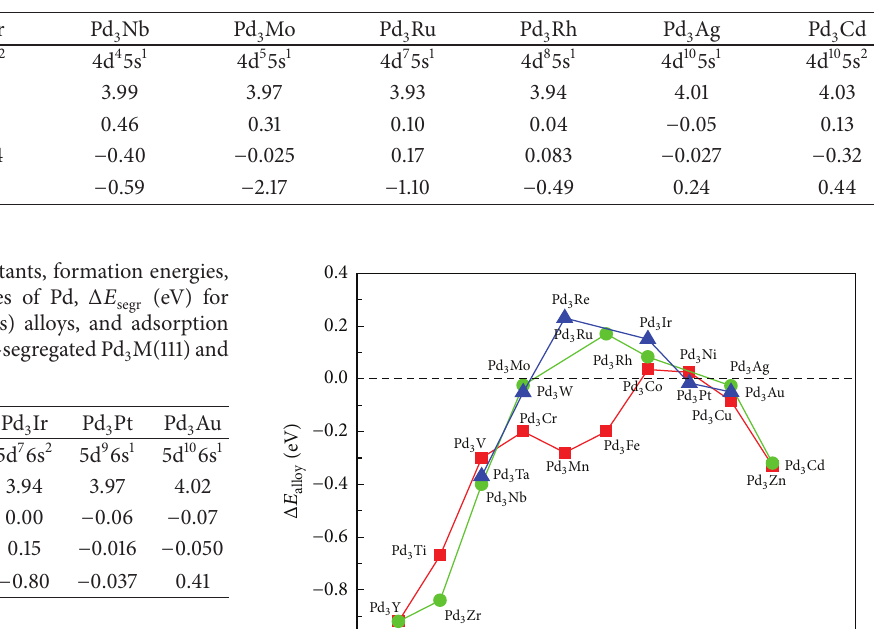
Table 2: The DFT calculated lattice constants, formation energies, Δ𝐸 M (M is 4d transition metals) alloys, and adsorption energies difference of O atom between Pd-segregated Pd Pd 3 Δ𝐸 (eV). O